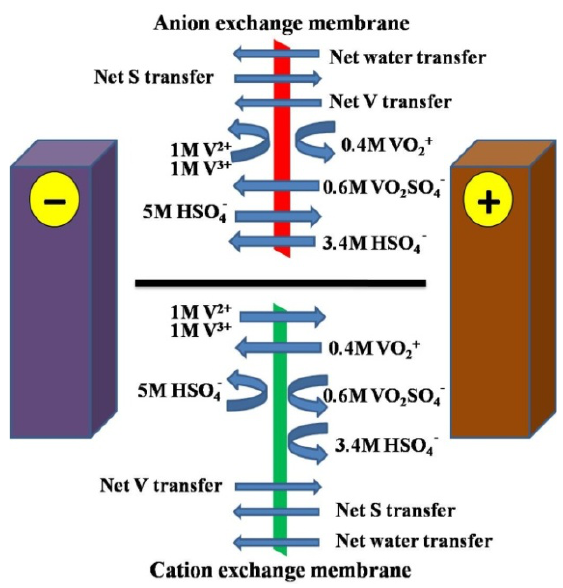
Figure 4. Expected movement of water and ions for Anion and Cation exchange membranes (Adapted from